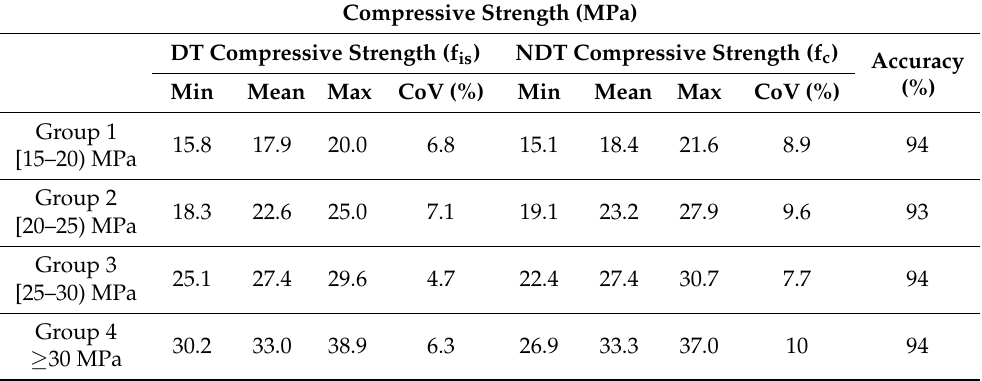
Table 2. Compressive strength.